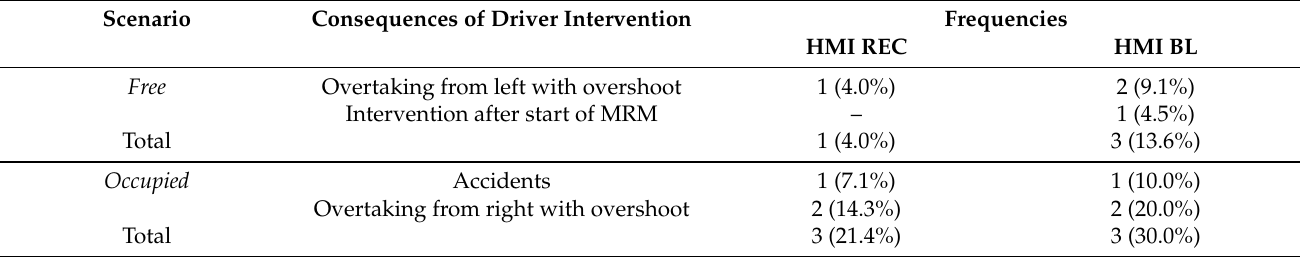
Table 3. Consequences of driver intervention and corresponding frequencies during the transi- tion phase.